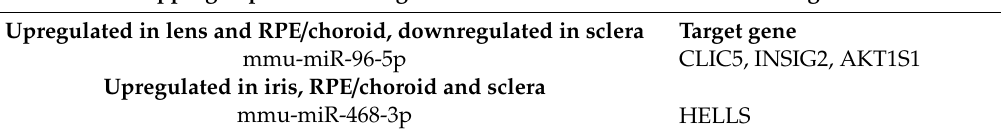
Table 14. The overlapping expression changes in miRNAs found in three ocular tissues and their target genes. Overlapping Expression Changes of miRNAs in Three Tissues and Target Gene Upregulated in lens and RPE / choroid, downregulated in